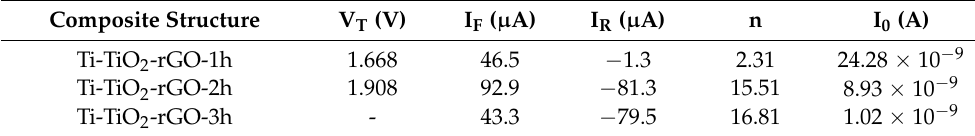
Table 1. Electrical parameters of the n -TiO 2 / p -rGO